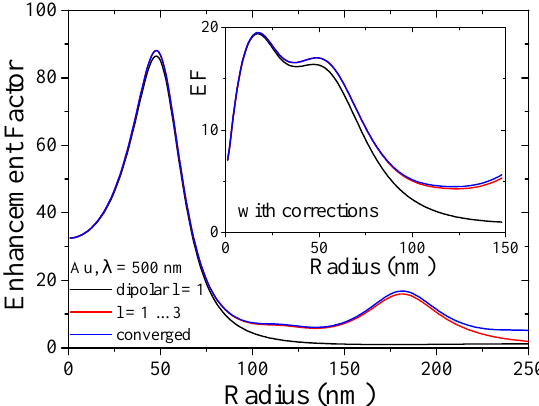
Figure 5. Size regime for multipolar response in metal nanoparticles. Enhancement factor EF = | E | 2 / | E at the particle surface, where the EF is maximized, for λ = 500 nm close to the corresponding Mie resonance of gold with classical Mie coefficients and as inset with combined microscopic corrections. The calculations are based on the dipolar response (black), the first three multipoles (red) and the converged result